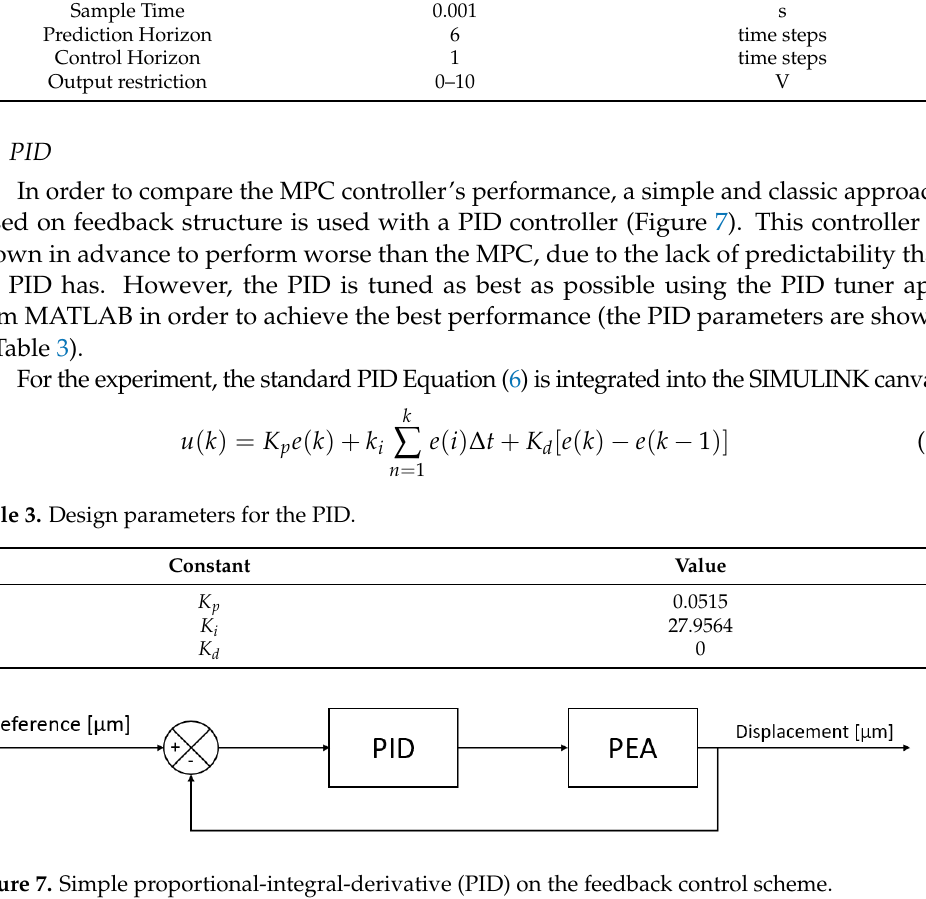
Figure 7. Simple proportional-integral-derivative (PID) on the feedback control